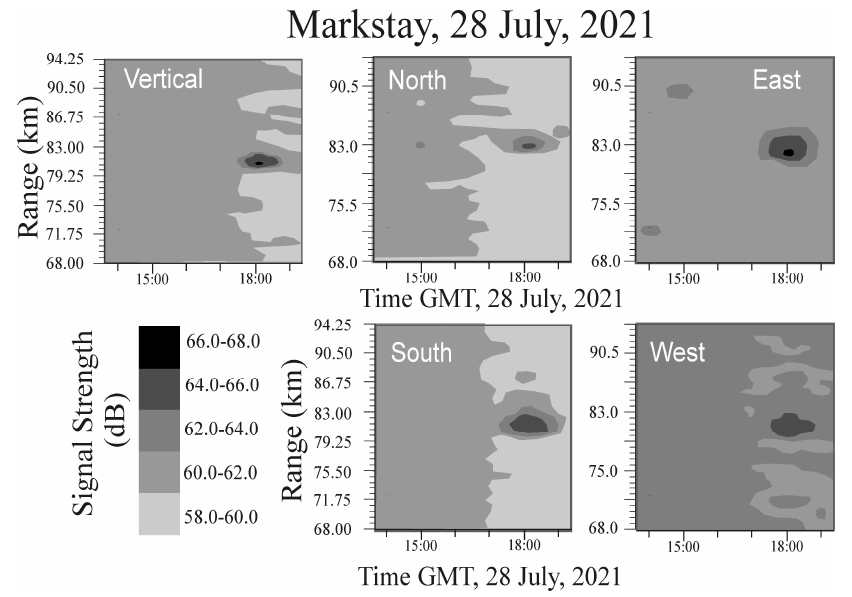
Figure 5. Mesospheric summer echoes recorded in 2021 with the Markstay radar. All 5 beams are shown in order to confirm that these were true mesospheric echoes.